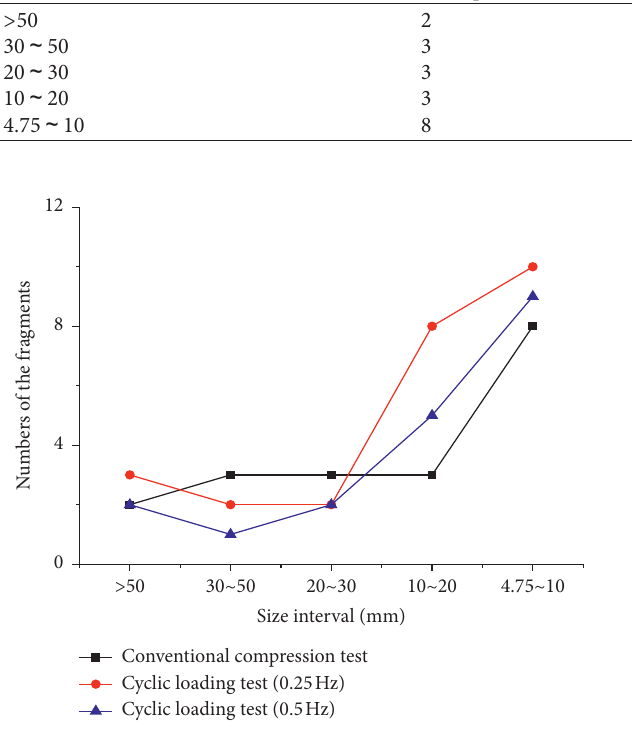
Figure 12: Number of limestone specimen fragments within different size intervals obtained under different test